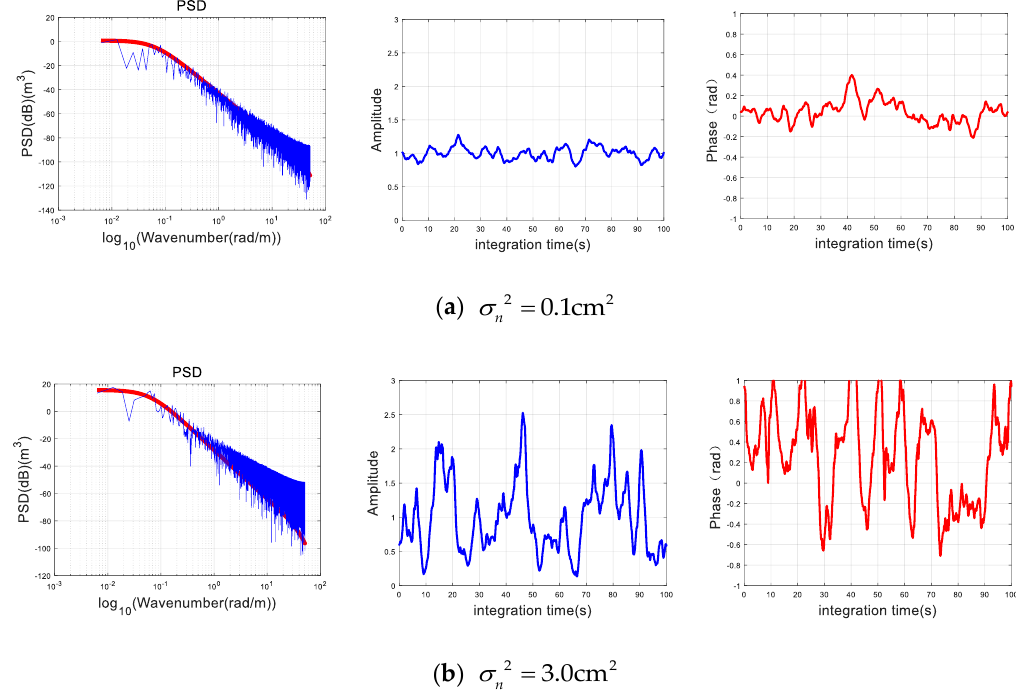
Figure 7. The power spectrum density, the amplitude and phase fluctuations at different turbulence intensities. ( a ) σ n 2 = 0.1 cm 2 ; ( b ) σ n 2 = 3.0 cm 2 . (Top: the power spectrum; bottom: amplitude and phase fluctuations.)